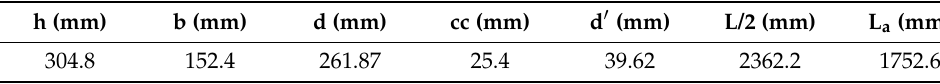
Table 4. The geometrical parameters for Decker (2007) beam.